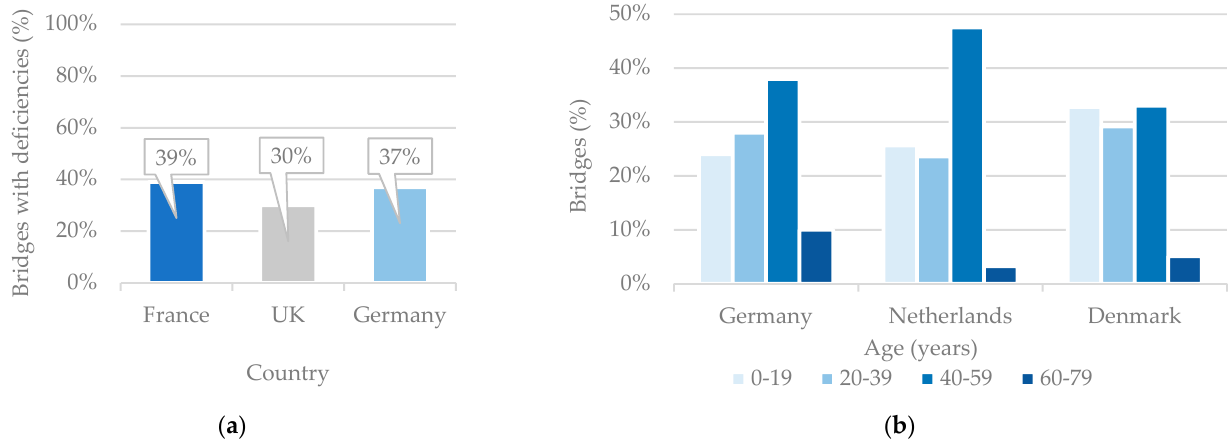
Figure 1. ( a ) Estimated percentage of highway bridges with deficiencies (adapted from [2]); ( b ): age of bridges in Germany, the Netherlands, and Denmark over the Trans-European Transport Network (TEN-T) (adapted from [3]).